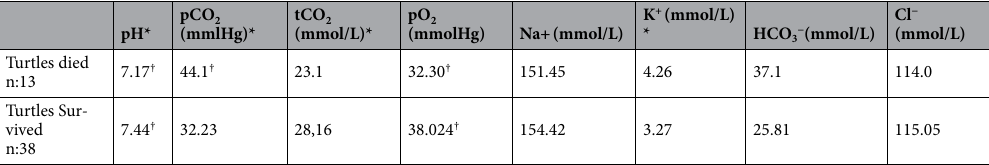
Blood analyte Cut off